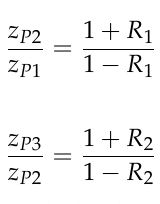
Table 2. Rock properties, A 0 and A 2 of the testing thin-bed model, units of velocities and densities are m/s and g/cm 3 ,